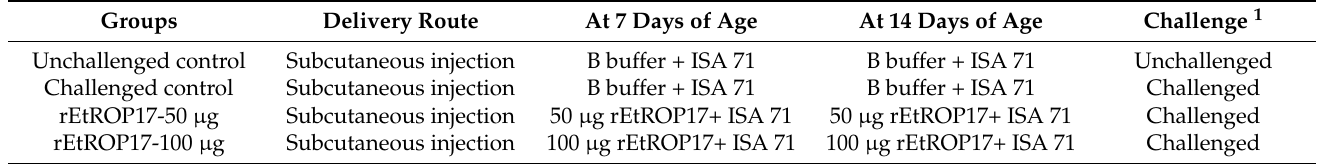
Table 1. Experimental design of immunizations and